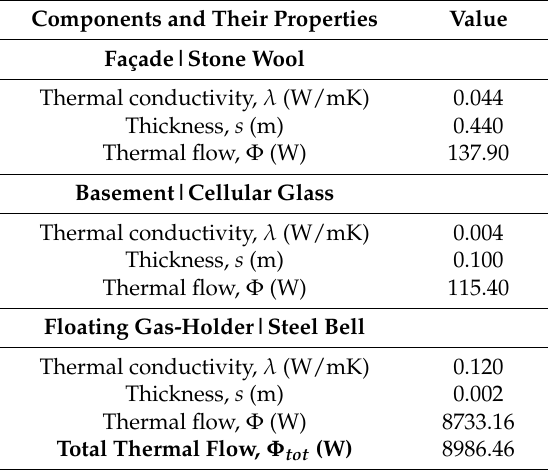
Table 1. A thermal characterization of the building